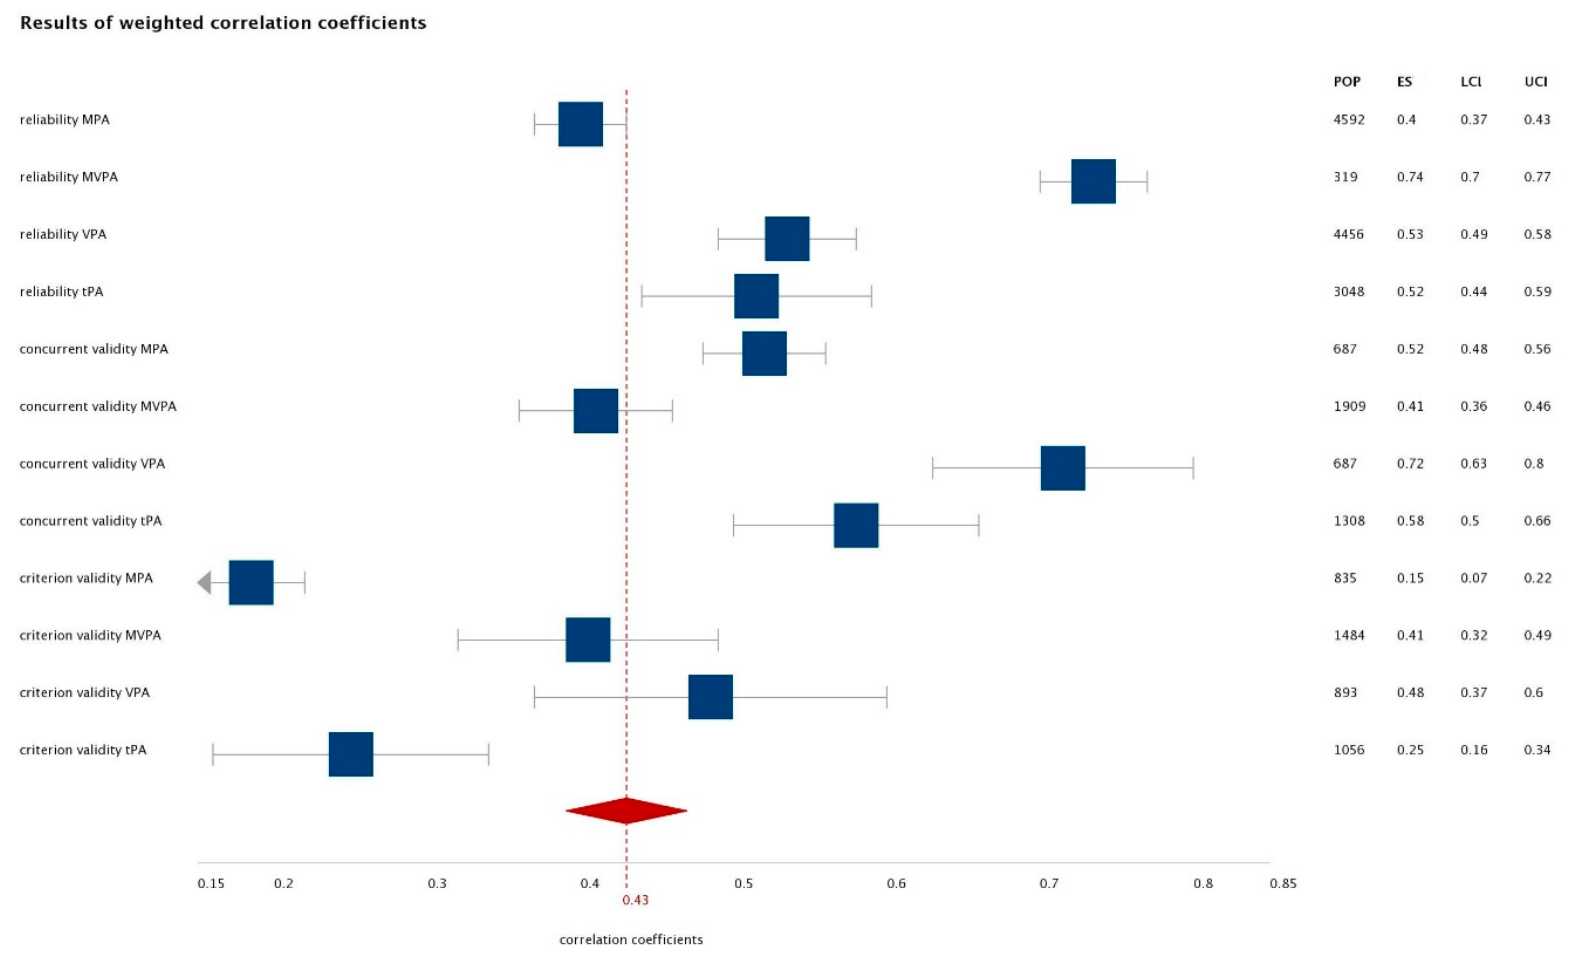
Figure 2. Forest plot of weighted correlation coefficients for measurement characteristics stratified by PA intensity (Note: POP—population; ESW—weighted ES; LCI—lower confidence interval; UCI—upper confidence interval).